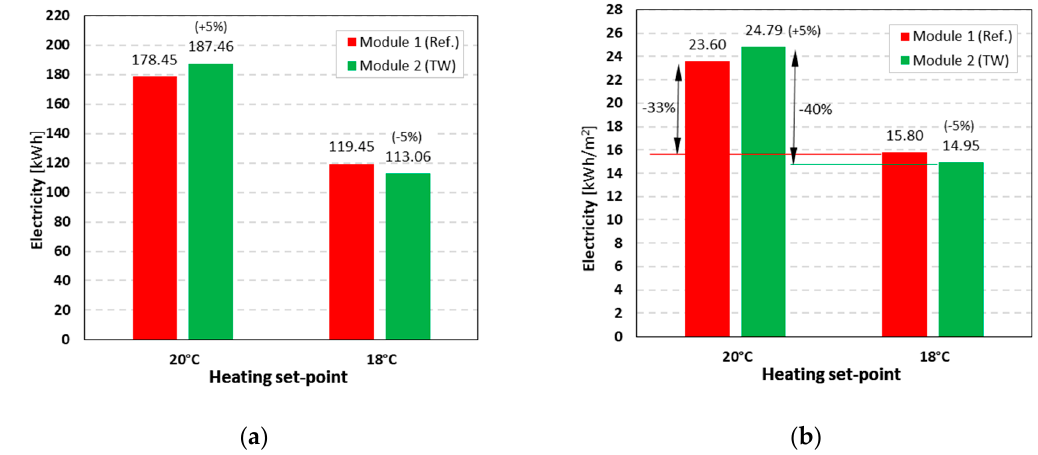
Figure 11. Predicted heating energy consumption (electricity) during the winter season in Coimbra (Portugal), assuming residential space use, for two different set-points: ( a ) Total values; ( b ) Normalized values.